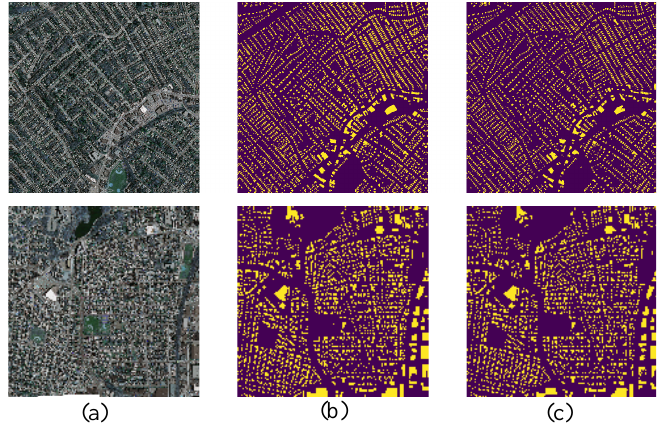
Figure 6. Building extraction results of our GMEDN model. Two images are randomly selected from the Massachusetts dataset. ( a ) Original image, ( b ) Ground truth, ( c )